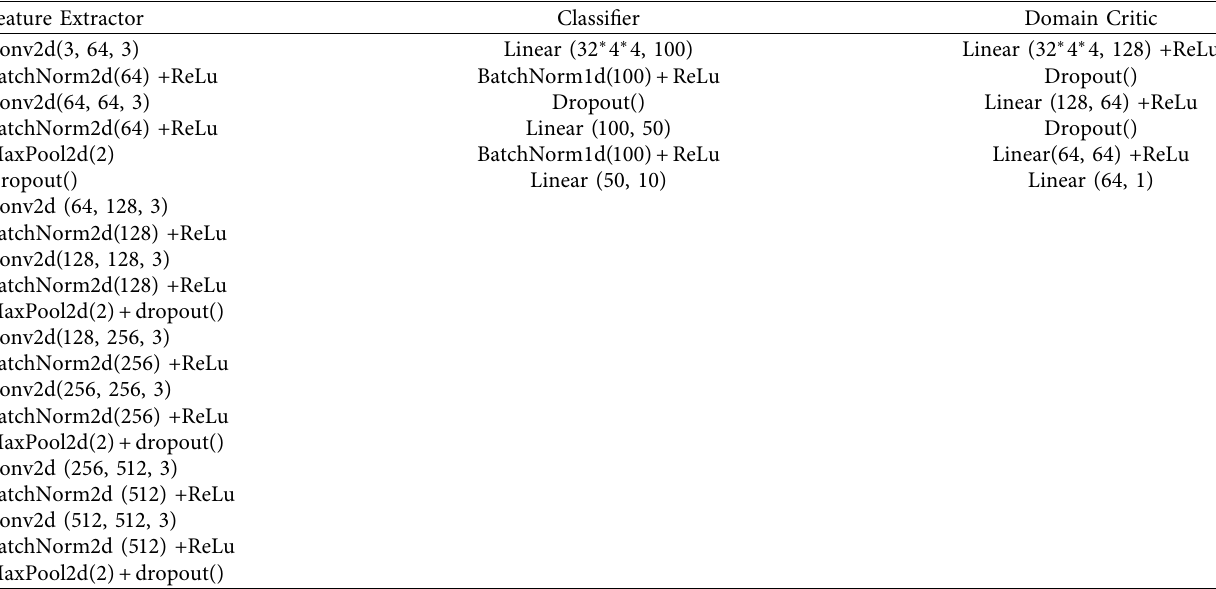
Table 4: Component architecture for CIFAR10.